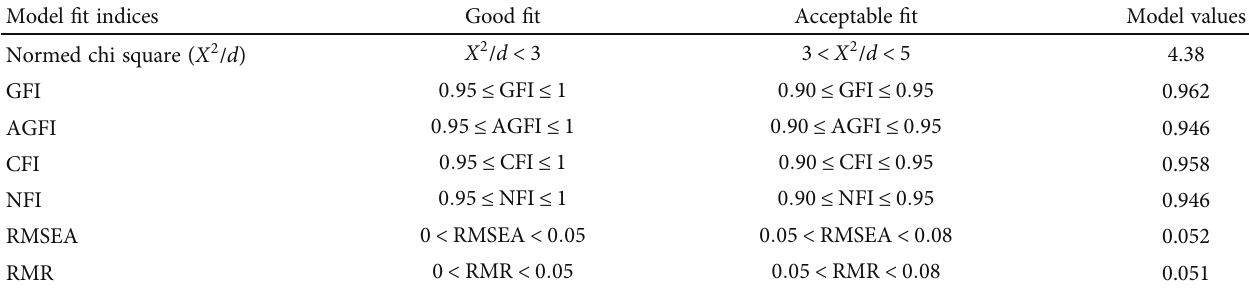
Table 2: Model fi t indices of con fi rmatory factor